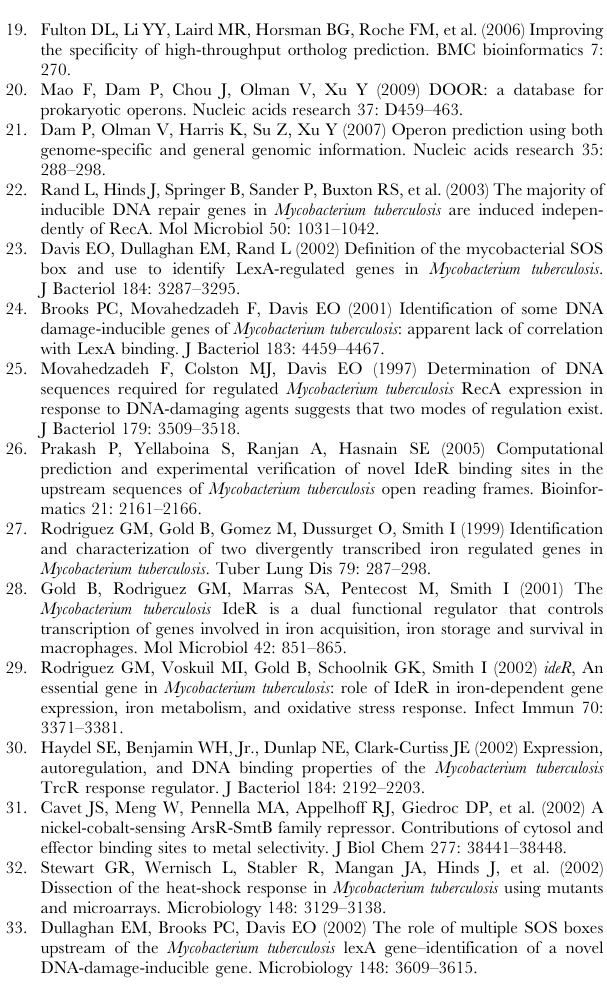
Table S1 DNA motifs in MycoRRdb mapped with regulatory regions reported in literature. (Available at: http://mycorrdb.